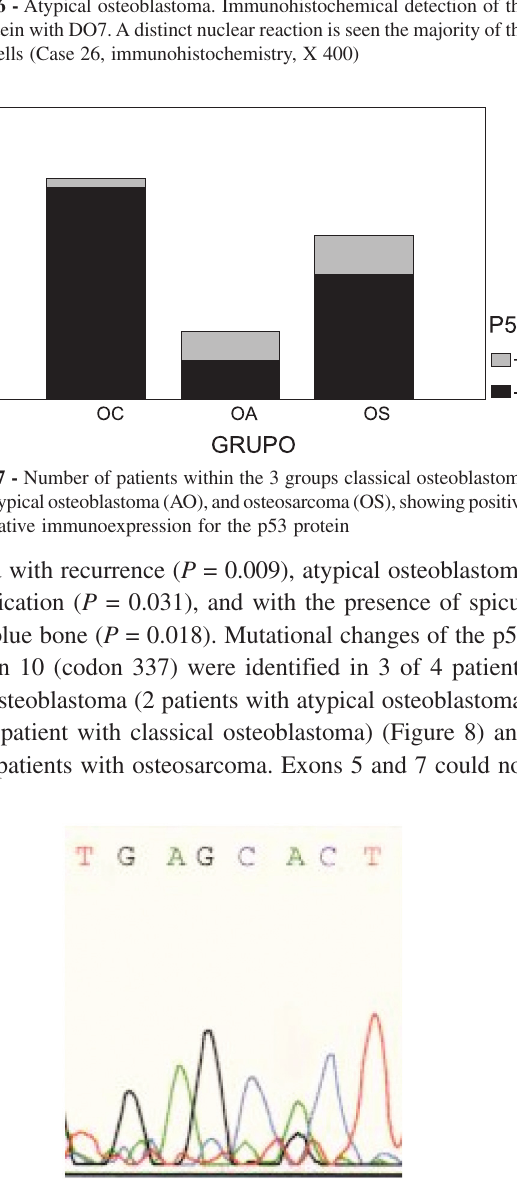
Figure 8 - Direct genomic sequence analysis of the p53 gene in patient no.30. Heterozygous G to A substitution in exon 10